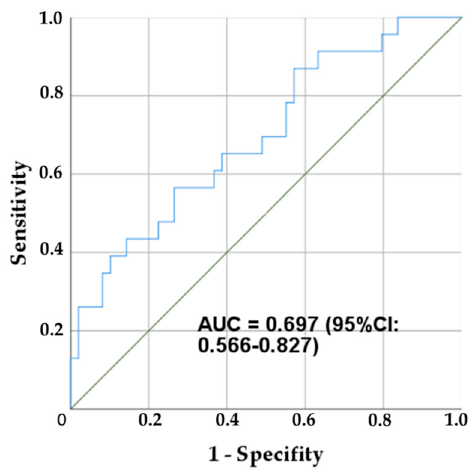
Figure 4. Receiver operating characteristic (ROC) curve for IL-6 concentration and the ability to discriminate between frail individuals versus robust plus pre-frail individuals.